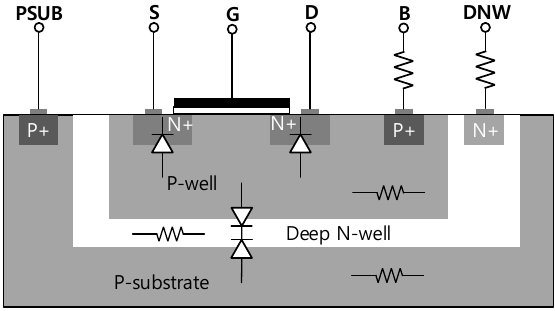
Figure 5. A schematic illustration of the double-well body-floating technique.